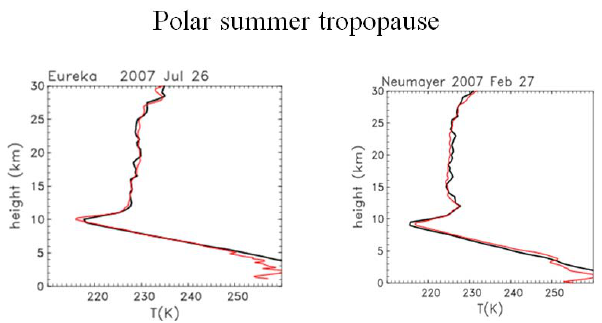
Fig. 14. COSMIC dry temperatures and high-resolution radiosonde temperatures showing sharp tropopauses at Eureka, Alaska (80 ◦ N, 86 ◦ W) 26 July 2007 and Neumayer in Antarctica (71 ◦ S, 8 ◦ W) 27 February 2007 (Randel and Wu, 2010).